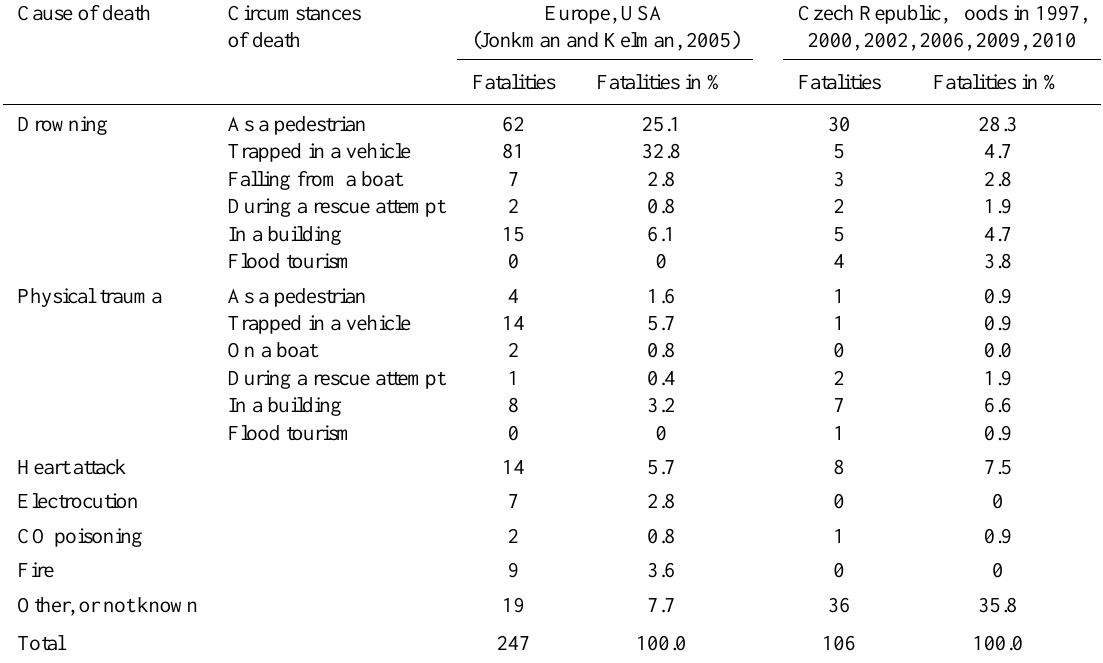
Table 3. Causes and numbers of fatalities during selected floods. Cause of death